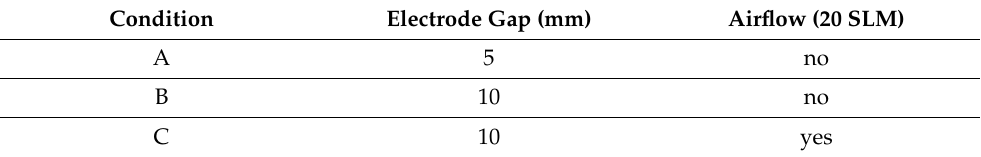
Table 1. Experimental conditions.